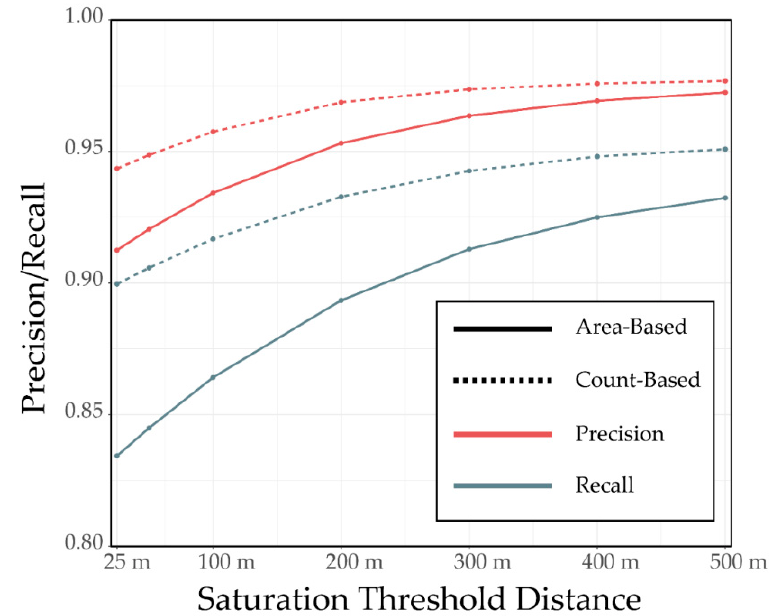
Figure 7. Impact of saturation threshold distance on resulting precision and recall estimates. Solid lines pertain to metrics derived from the area-based method while a dash pattern represents those obtained from the count-based method. The point and line color differentiate the assessment metric (precision or recall).